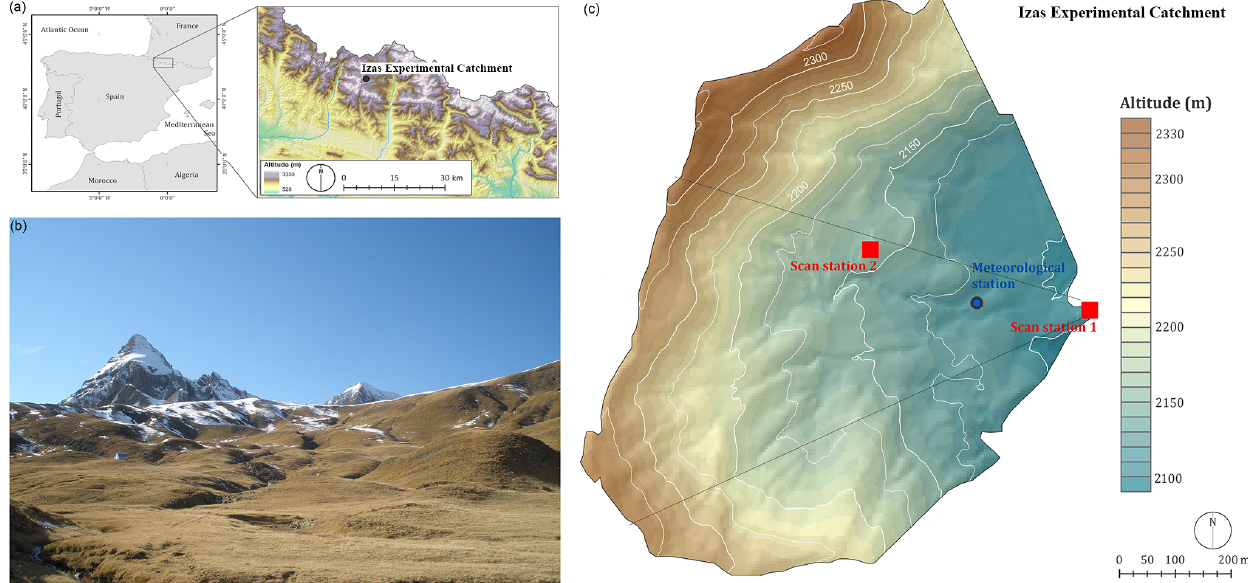
Figure 1. The Izas Experimental Catchment study site. Panel (a) shows the location of the study site. Panel (b) shows an overview of the catchment with marginal snow presence. The right map (c) shows the topographic characteristics of the catchment and the location of the TLS scanning positions (Scan stations), the meteorological station and the field of view of the time-lapse camera (continuous lines from Scan station